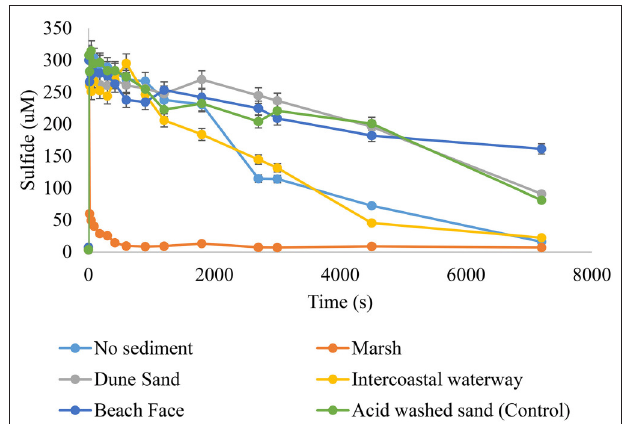
FIGURE 3 | The effect of sediment slurries on sulfide oxidation. Sediment suspensions (1.00 wt%) were made up in pH adjusted seawater. Suspensions were maintained and aerated through rapid mixing. At time = 0s sufficient HS − (aq) was added to bring its solution concentration 300 µ M. HS − was monitored for a minimum of 7200s from zero. Results from pH 8.25 shown.